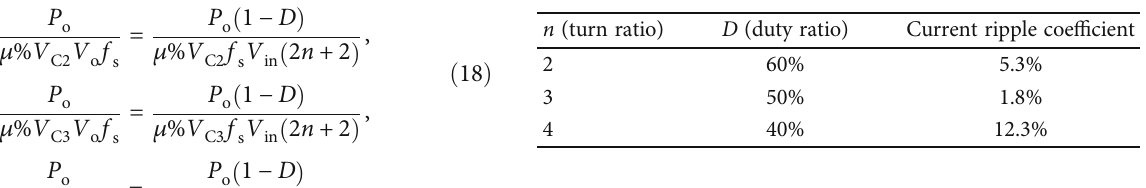
Figure 11: Input current ripple under di ff erent duty ratio and turn number ratio. Table 3: Input current ripple coe ffi cient under di ff erent turn number ratio and duty cycle.